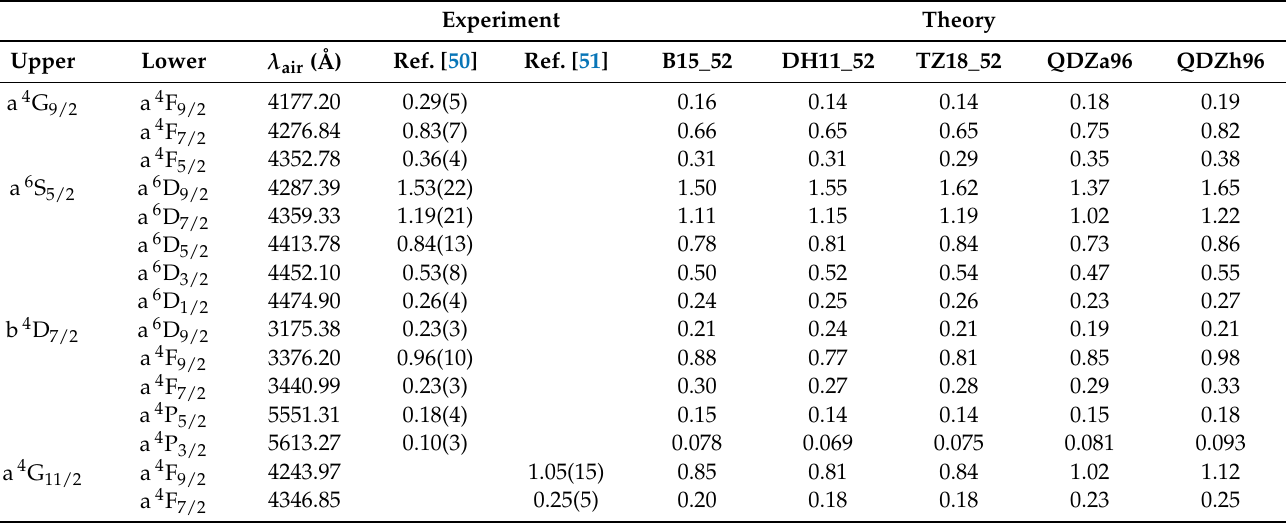
Table 13. Comparison of experimental A -values (s − 1 ) for transitions in [Fe II ] with those listed in the revised PyNeb atom datasets. The error of the least significant figure of the observed A -value is indicated in